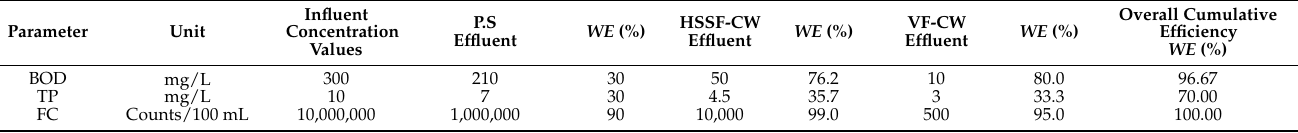
Table 4. Effluent water quality of each treatment